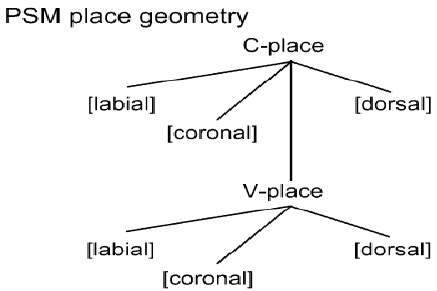
Figure 7. The parallel structure model (Youssef 2015, p. 80).